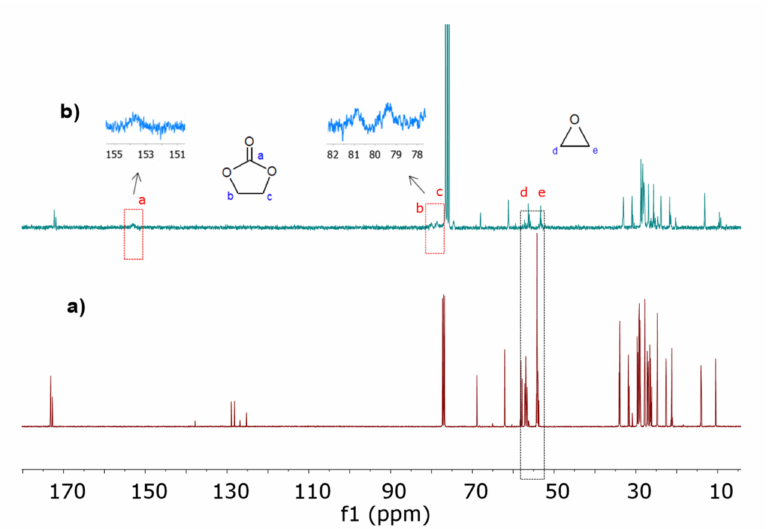
Figure 3. Carbon-13 nuclear magnetic resonance ( 13 C-NMR) spectra of ( a ) ELO and ( b )